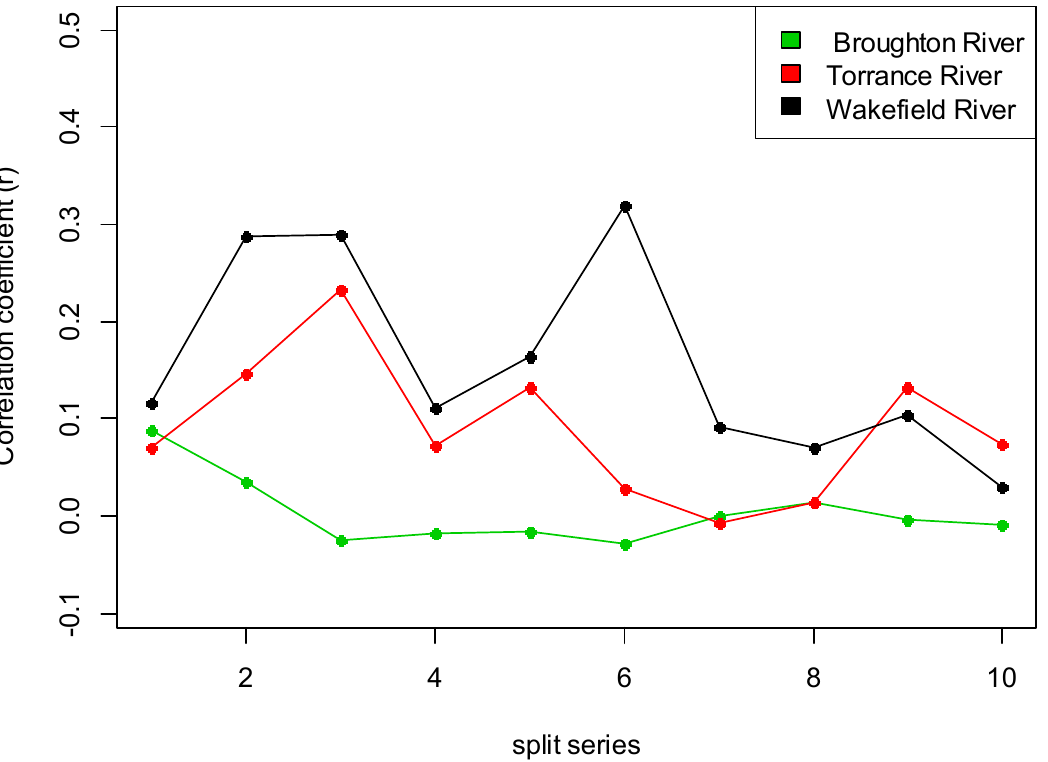
Figure 2. Correlation pattern subseries of rainfall and stream flow time